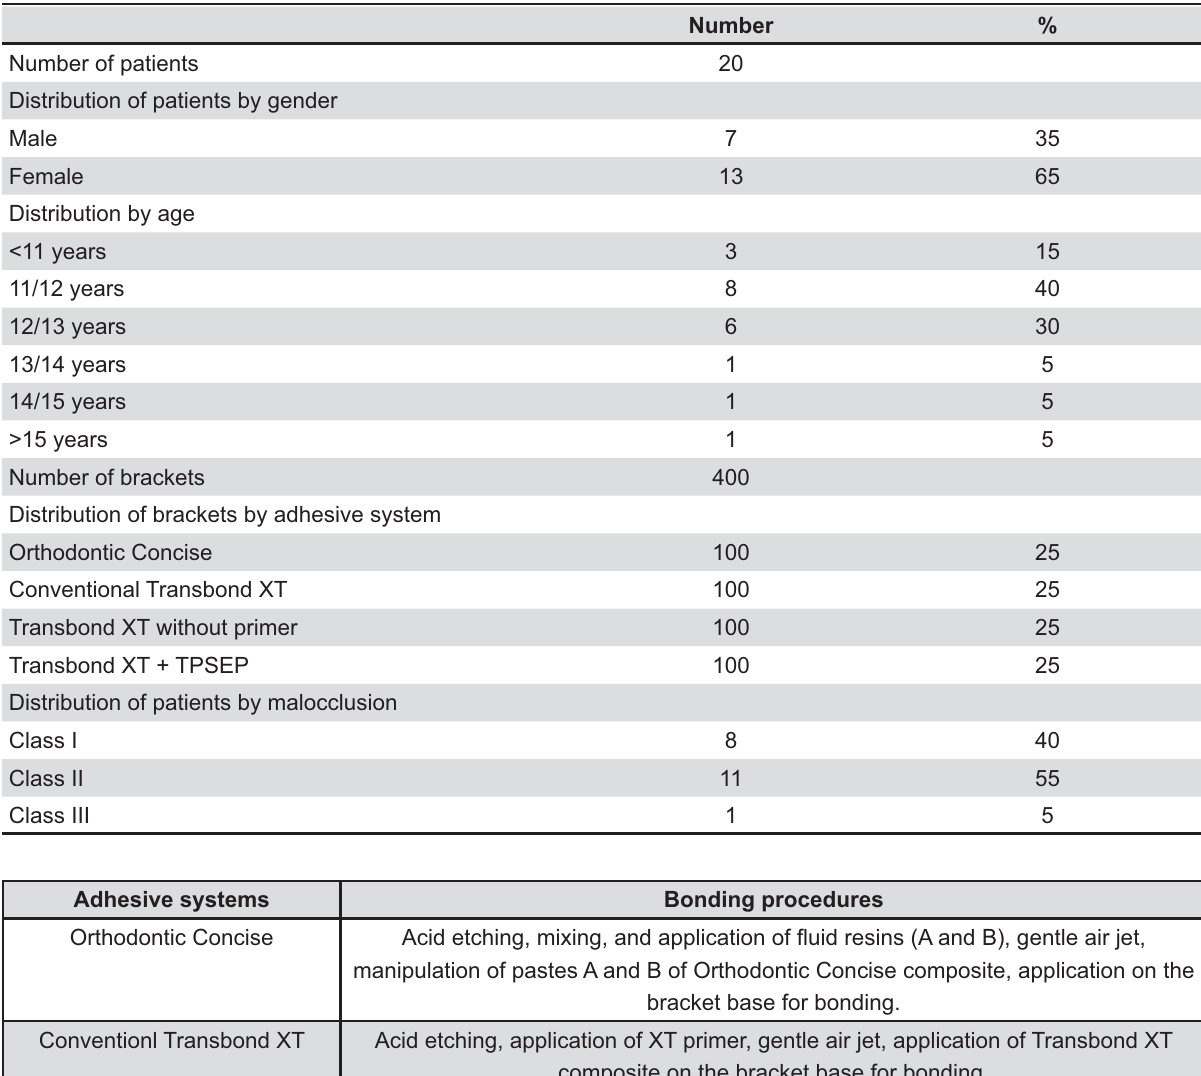
Table 1- Sample characteristics